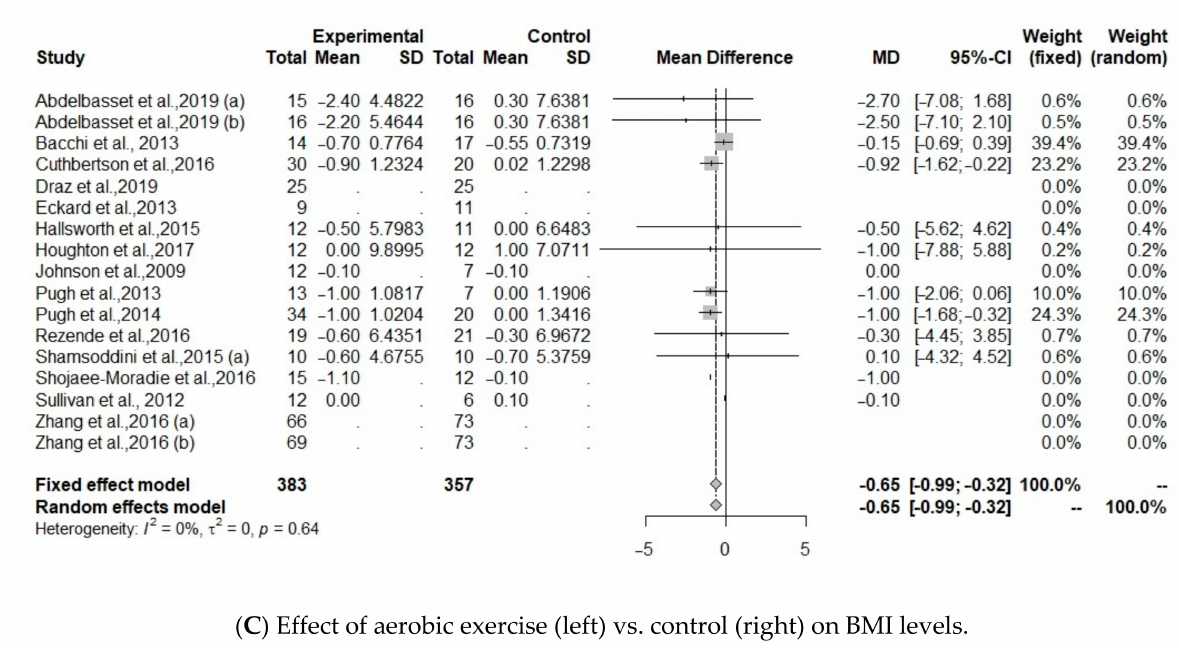
Figure 3. ( A ). Effect of continuous and interval aerobic exercise (left) vs. usual care (right) on ALT levels in patients with MAFLD; ALT, alanine aminotransferase. ( B ). Effect of exercise (left) vs. control (right) on IHTG levels; IHTG, intrahepatic triglycerides. ( C ). Effect of exercise (left) vs. control (right) on BMI levels; BMI, body mass